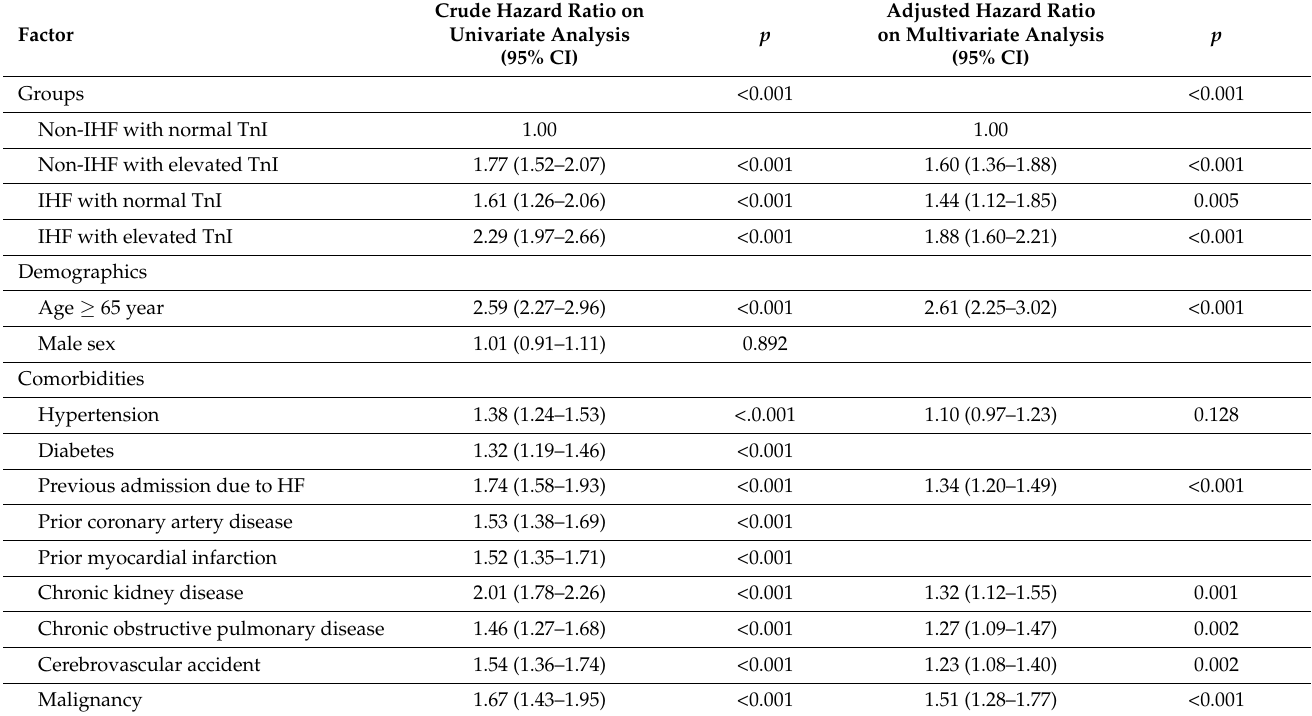
Figure 1. Kaplan–Meier survival curve according to the etiology of HF and status of TnI. IHF, ischemic heart failure; TnI, high-sensitivity troponin-I. Table 2. Multivariate Cox proportional-hazards model for the factors associated with overall all-cause